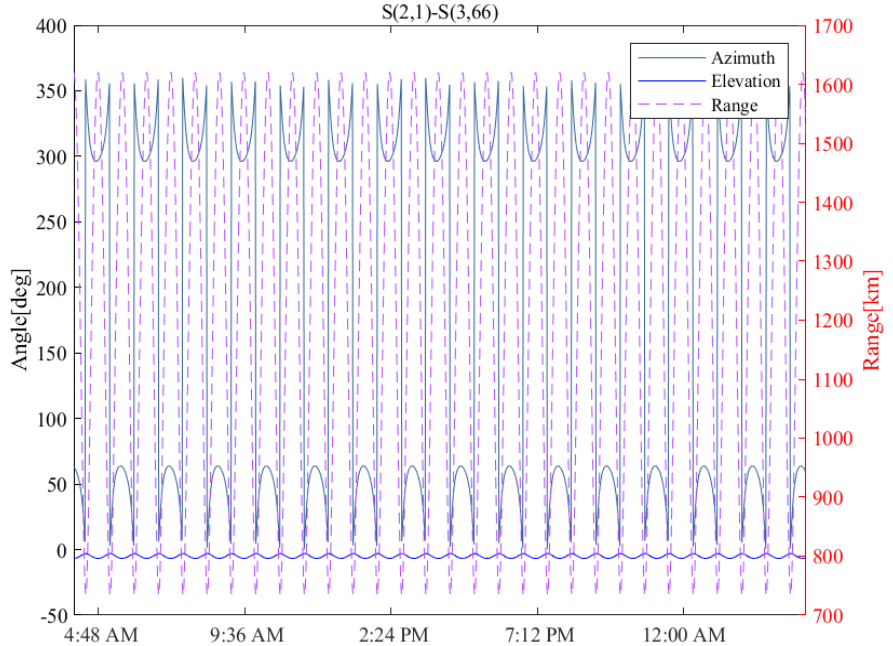
Figure 14. Characterization of the adjacent orbital link AER.